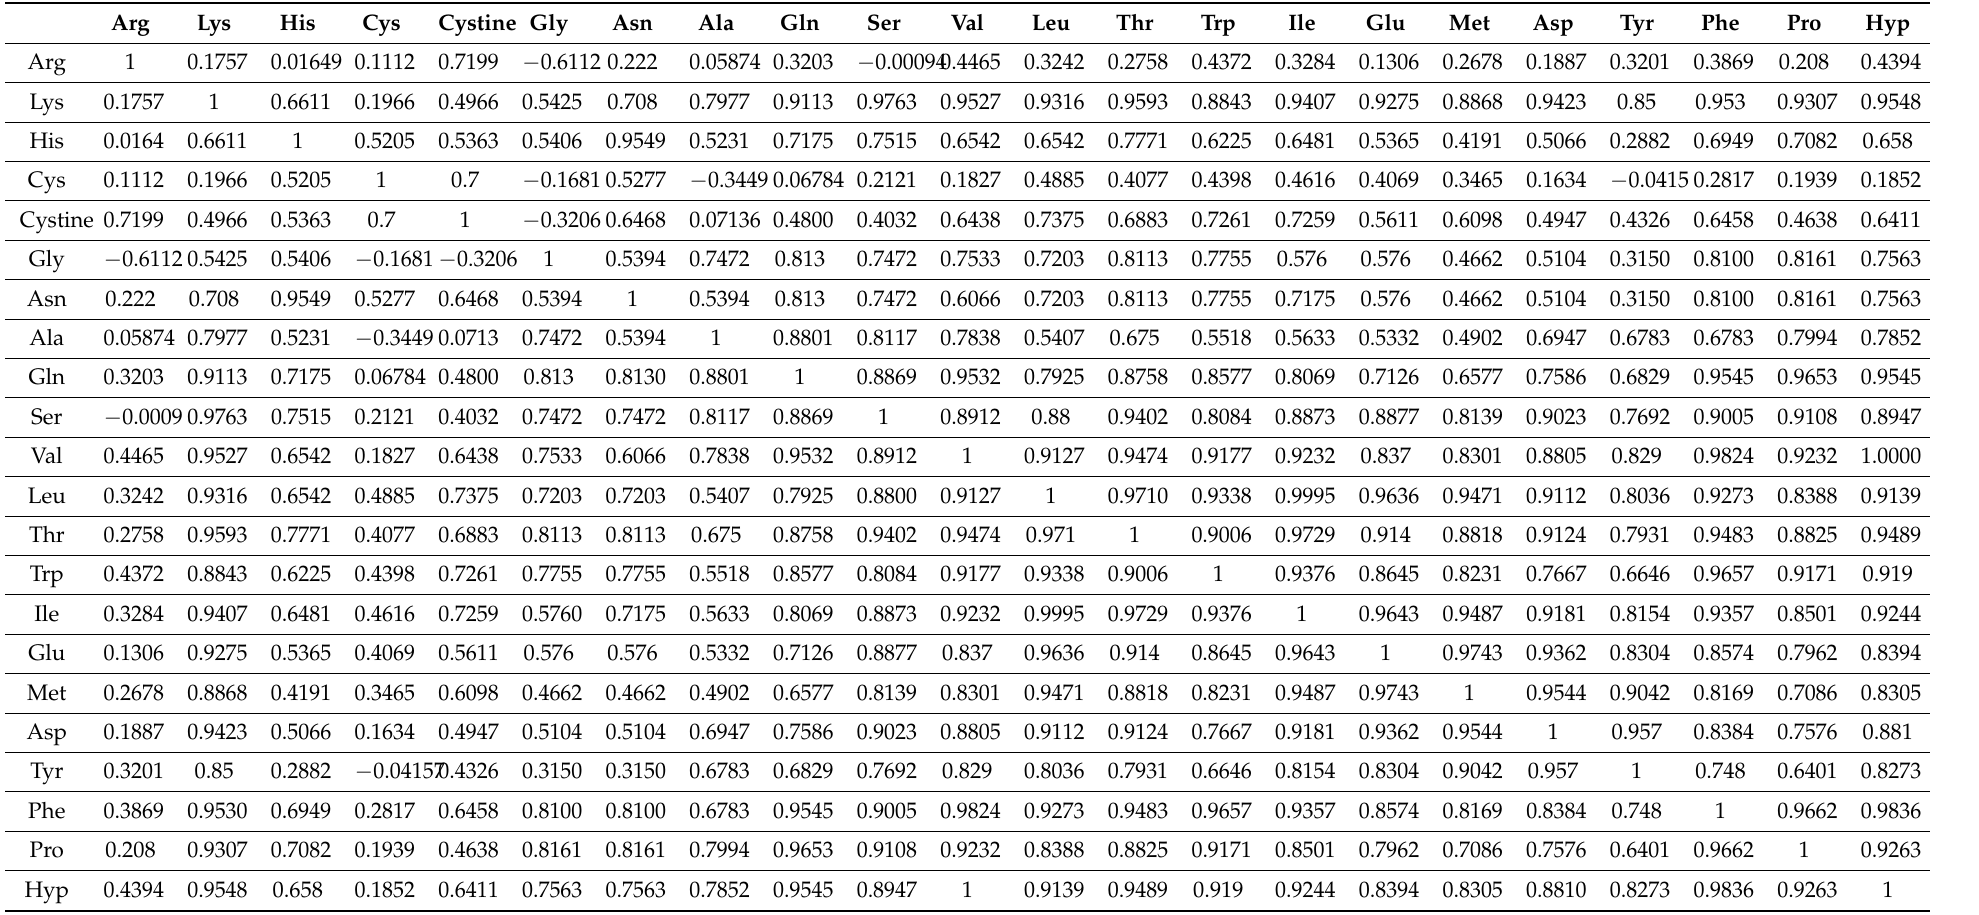
Table 4. Pearson correlation of amino acid content in resultant Sauvignon blanc